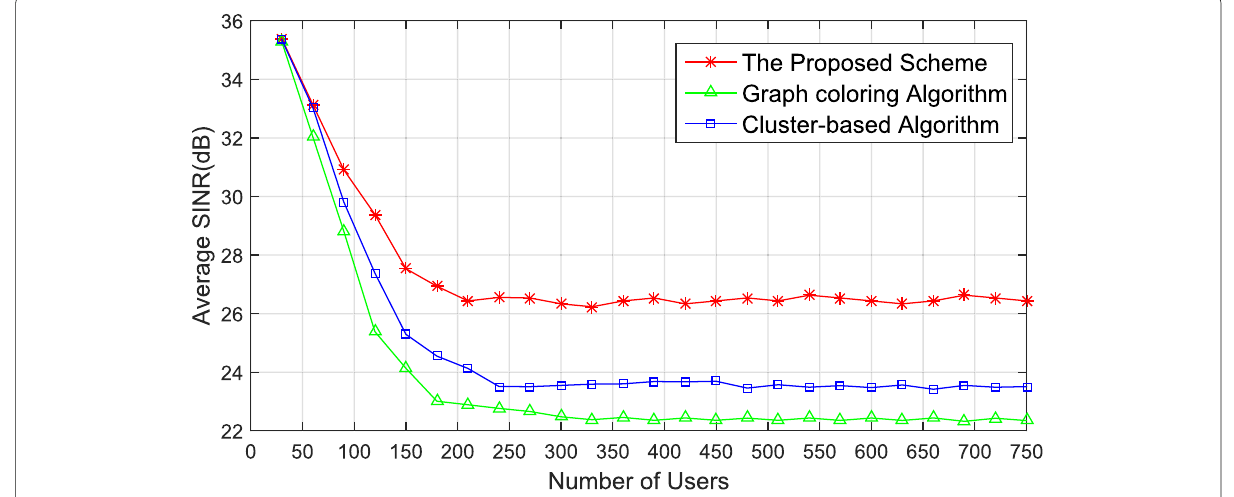
Fig. 7 Comparison of average SINR. Users include those with access and those denied